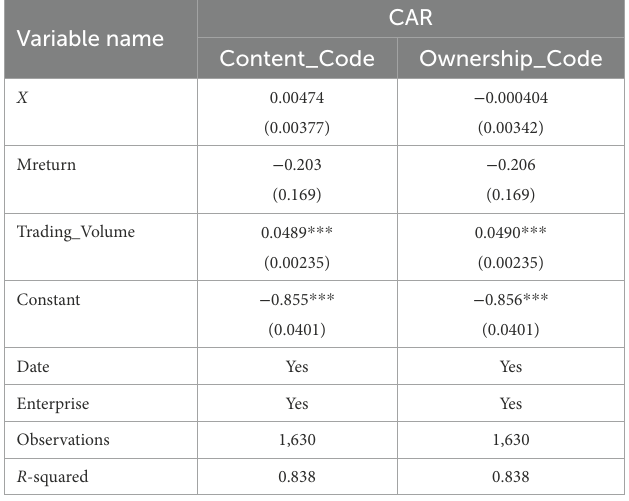
TABLE 6 Robustness tests of counterfactual ideas.